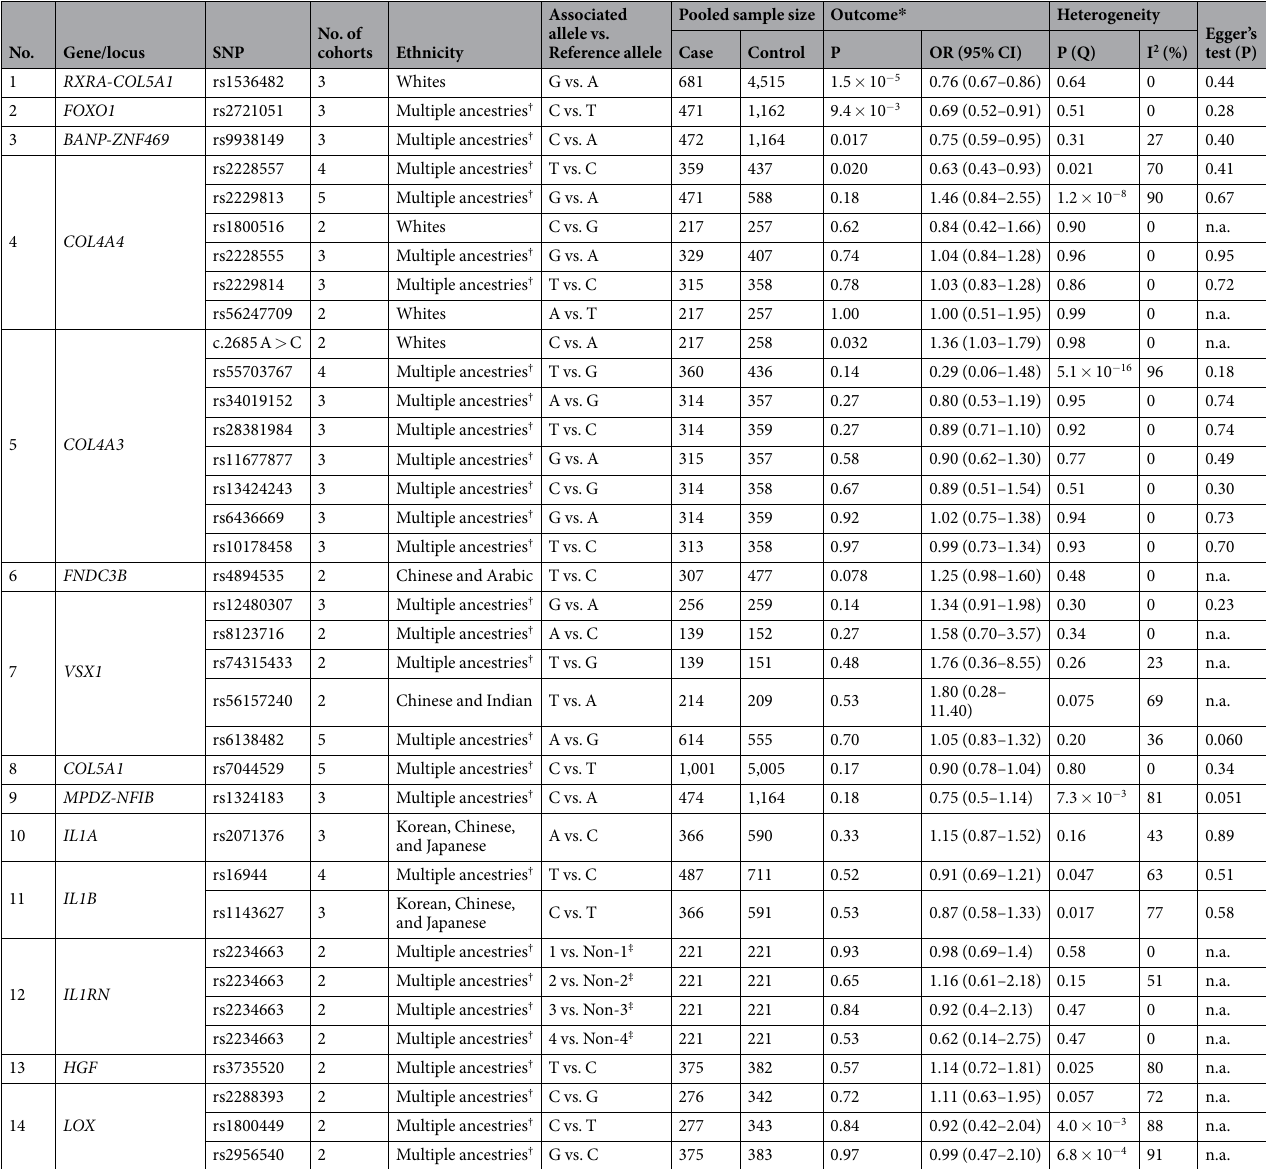
Table 3. Allelic associations of gene variations with keratoconus based on purely candidate gene studies. * A random-effects model was used. † Multiple ancestries included 2 or more ethnic groups from Whites and Asian (Arabic, Chinese, Korean, Japanese, or Indian). ‡ IL1RN rs2234663 were designated as IL1RN ∗ 1 [4 repeats, 410 base pairs (bp)], IL1RN ∗ 2 (2 repeats, 240 bp), IL1RN ∗ 3 (5 repeats, 500 bp), IL1RN ∗ 4 (3 repeats, 325 bp), and IL1RN ∗ 5 (6 repeats, 595 bp). CI = confidence interval; OR = odds ration; SNP = single nucleotide polymorphism; n.a. = not applicable; No. =